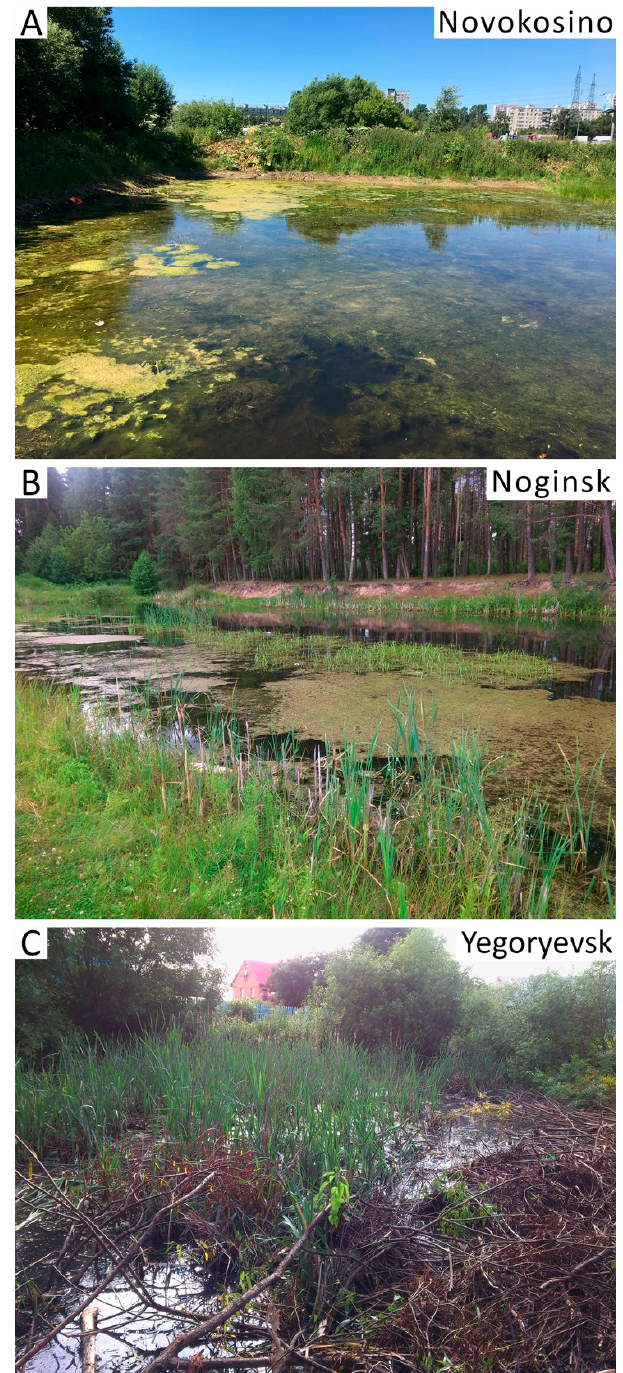
Figure 3. Mosquito breeding sites in Novoskosino ( A ), Noginsk ( B ), and Yegoryevsk ( C ). Ponds in Novokosino and Noginsk are preferred by An. messeae and represent typical for Anopheles sunny larval breeding sites with open water and abundant vegetation. The water reservoir in Yegorevsk, preferred by An. daciae , is shaded and characterized by high water saprobity.